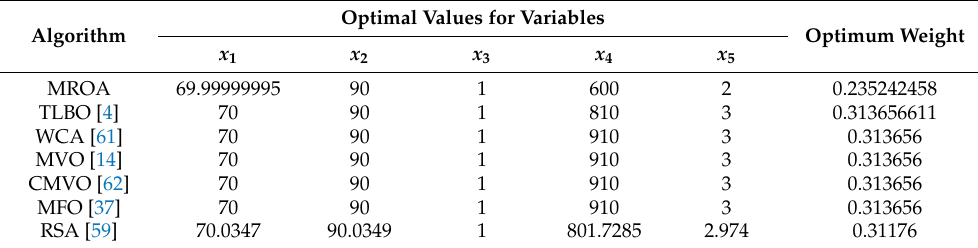
Table 15. Results of optimal solutions for multiple disc clutch brake design